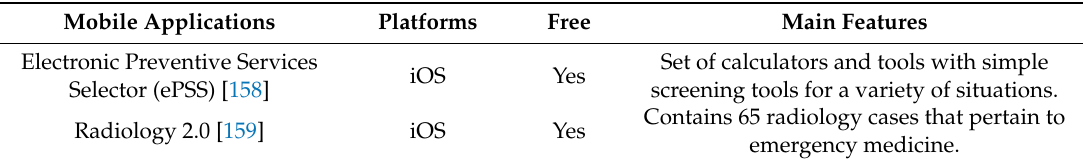
Table 5. Mobile health applications related to specialty